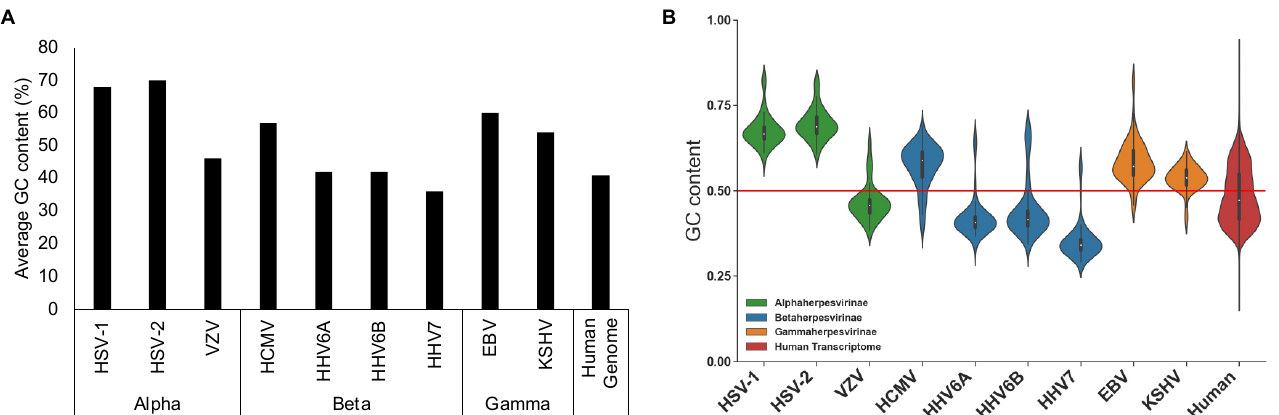
Figure 1. Average GC content of human herpesvirus genomes. ( A ) The average GC content was calculated based on the total number of G + C nucleotides divided by the total genome length. Calculations were based on the reference genome for each herpes virus. ( B ) GC content of human herpesvirus open reading frames and the human transcriptome. Human transcriptome data were based on GRCh38 RefSeq Transcripts. Red line indicates 50% GC content for visual